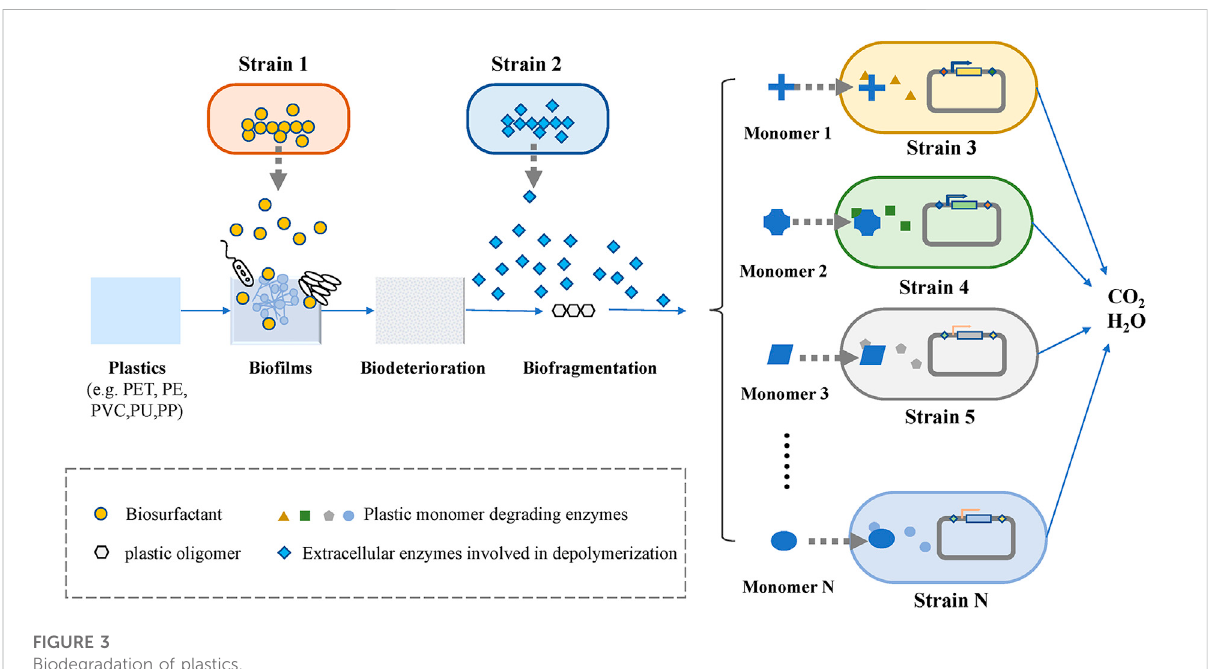
FIGURE 3 Biodegradation of